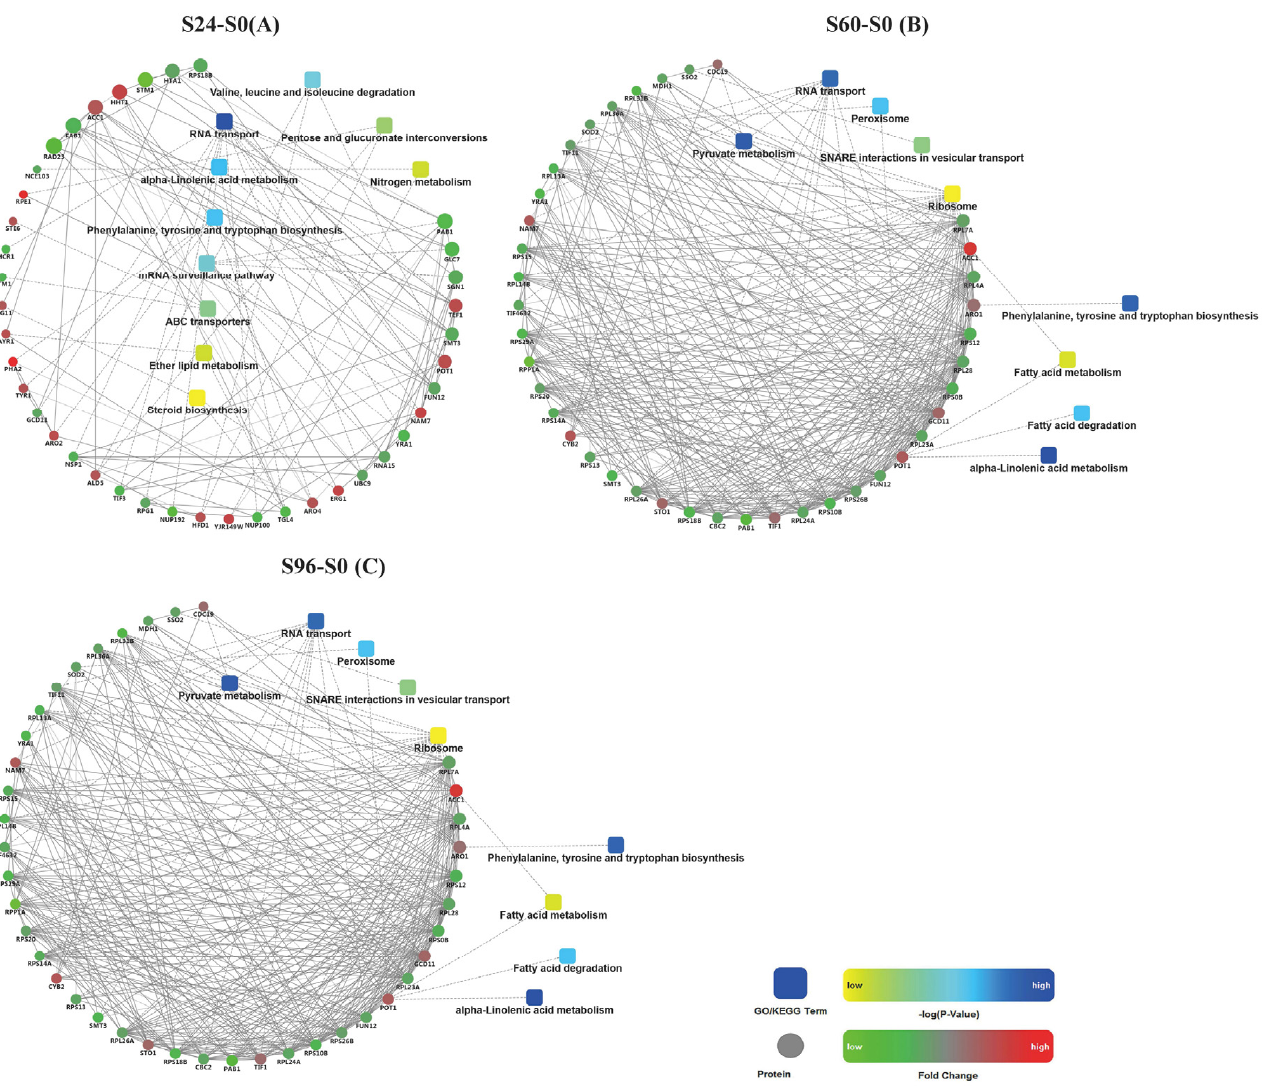
Figure 7. PPI network diagram. ( A ): S24–S0; ( B ): S60–S0; and ( C ): S96–S0. Note: Dots represent proteins, red represents up-regulated expression, and green represents down-regulated expression. Rounded rectangles represent biological processes, cell localization, molecular functions, or signaling pathways; blue represents high significance, and yellow represents low significance. Straight lines represent the interaction relationship, the solid lines represent the relevant relationships verified in this report, and the dashed lines represent relationships unconfirmed by this experiment.